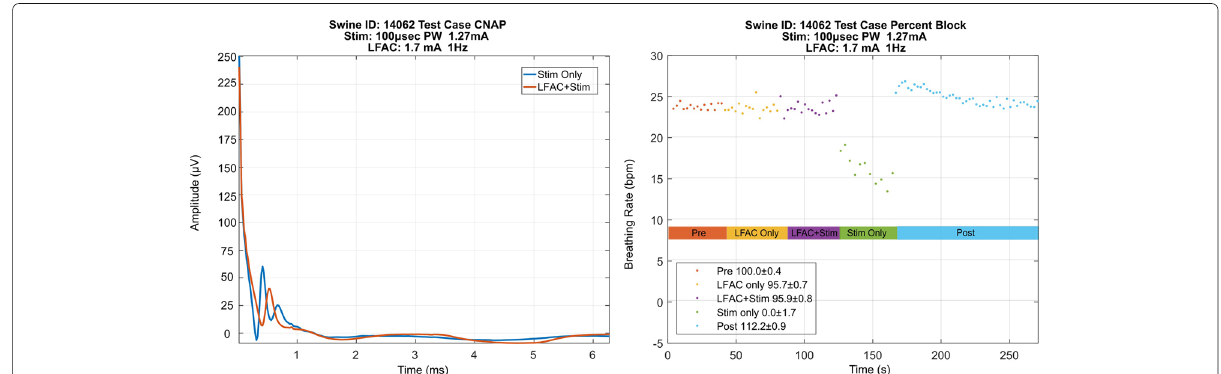
Fig. 8 ENG recordings during an LFAC test case. In the ’Stim Only’ epoch (left panel) there are 2 clear CNAPs. The LFAC waveform during ’LFAC+Stim’ slow these CNAPs down and cause a decrease in amplitude. The right panel shows the breathing rate and percent block ( ± SD) during ’Stim Only’ and ’LFAC+Stim’